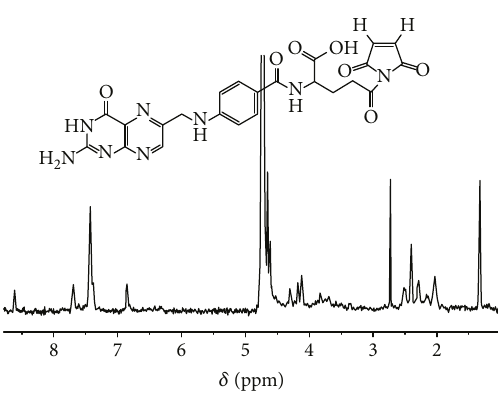
Figure 1: The structure and 1H NMR spectrum of crosslinkable